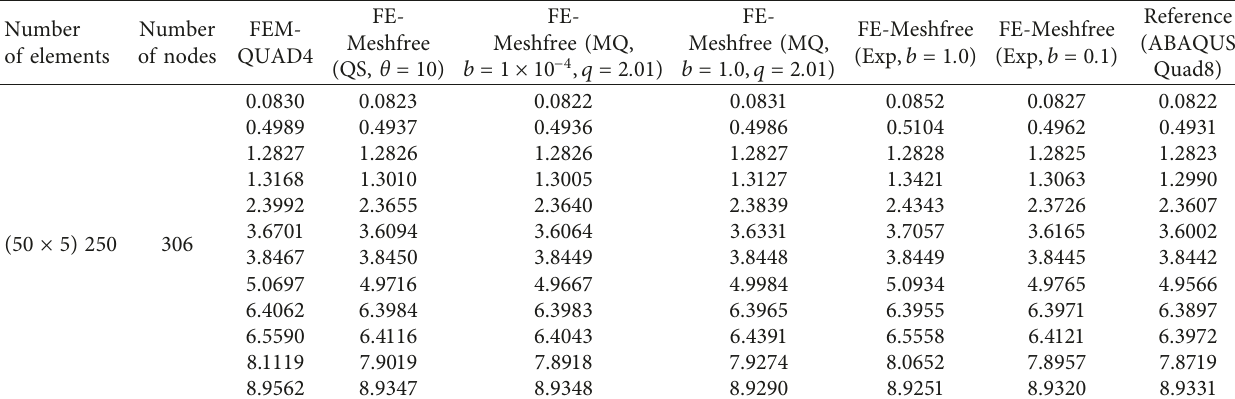
Table 6: Natural frequencies ( × 10 4 Hz) of a cantilever beam for 250